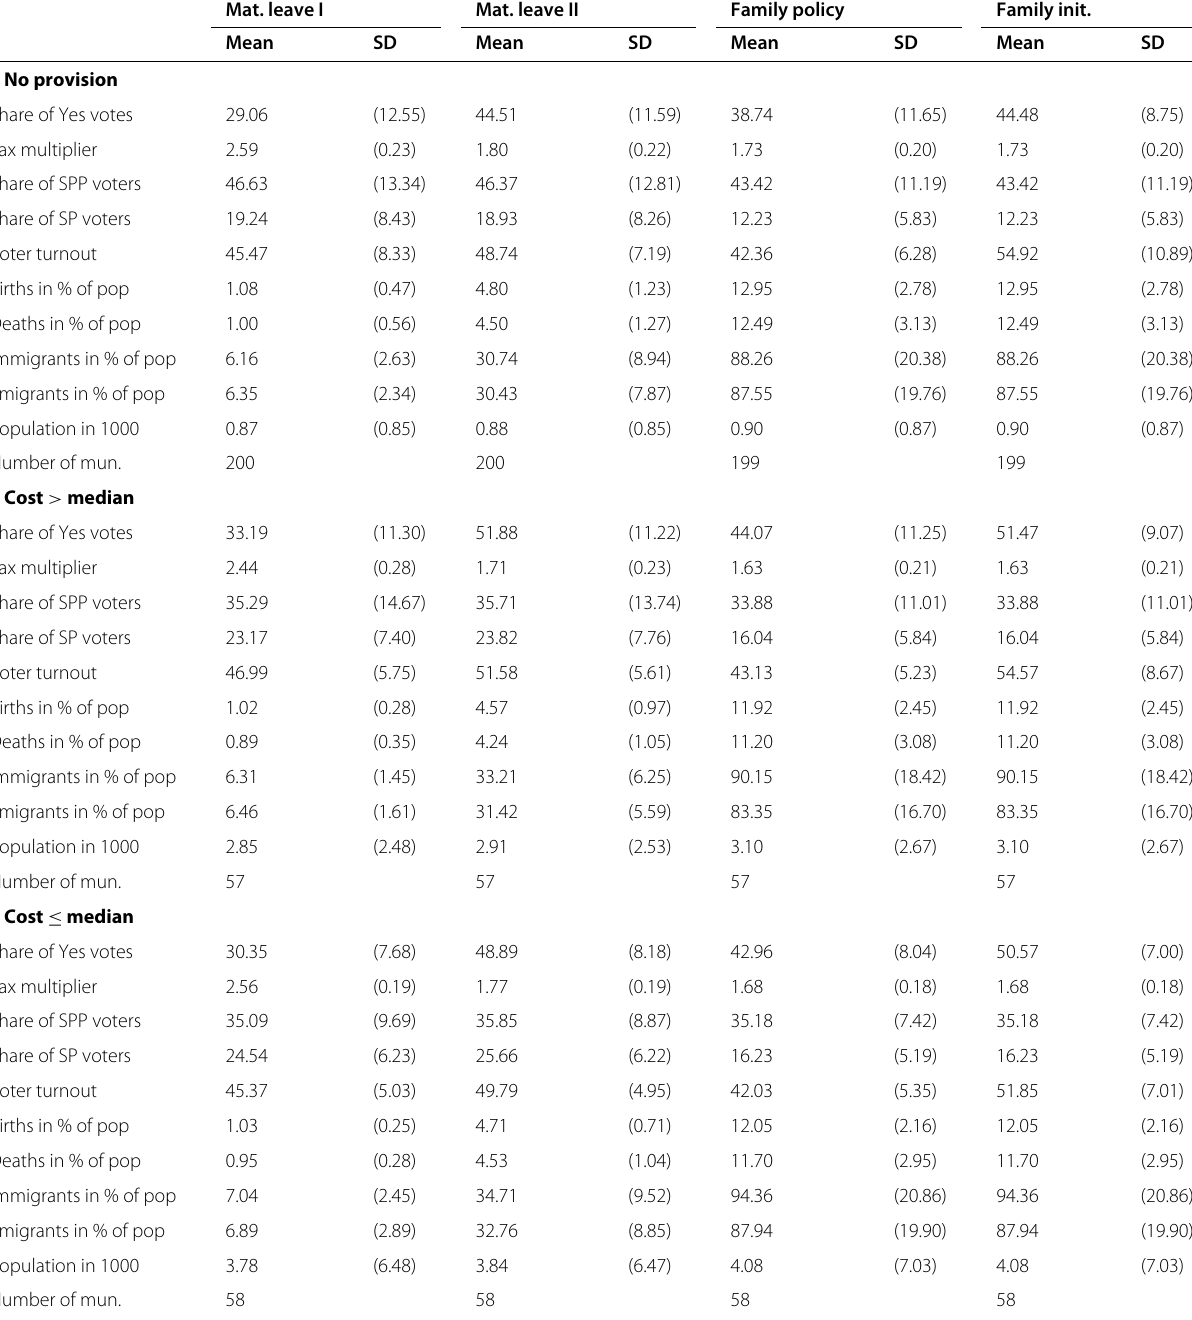
Table 13 Descriptive statistics for municipalities with the canton of Bern